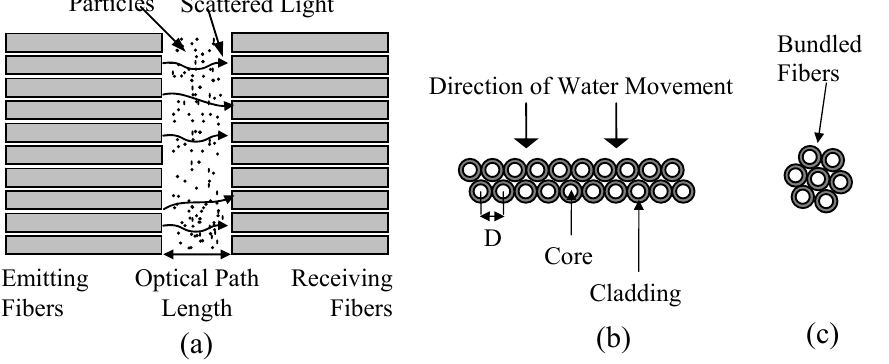
Figure 3. Configurations for (a) PCOS and FIT Experimental Setup (b) Two Adjacent Linear Fibers Layers (c) Bundled Fibers